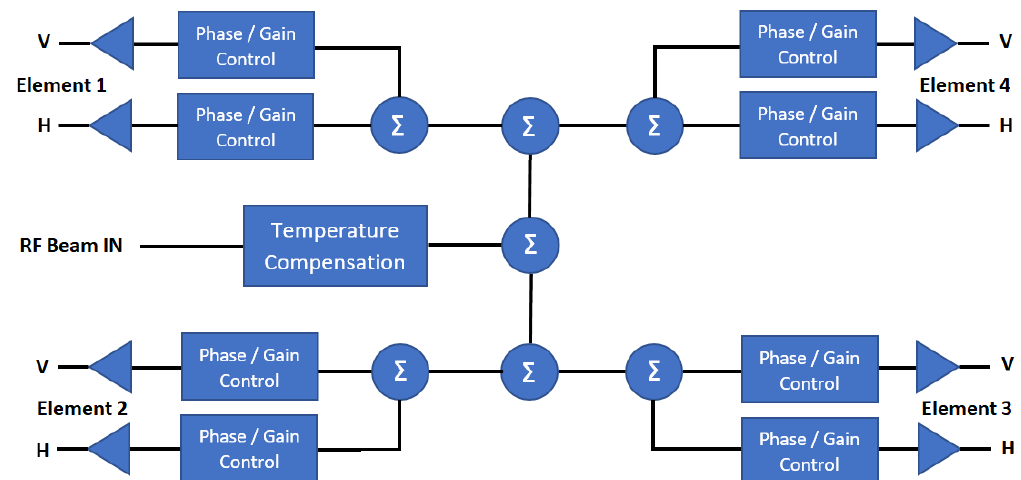
Figure 2. Block diagram of the Ka-band transmit beamformer chip.